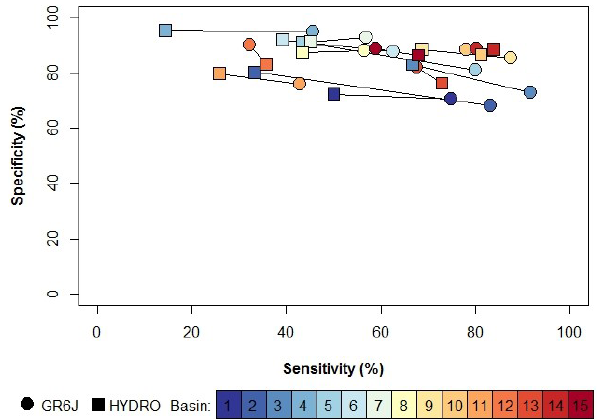
Figure 7. Skill scores obtained for the WRL model over the pe- riod 2005–2013. Each segment is related to one of the 15 catch- ments listed in Table 2. The endpoints refer to the source of dis- charge data (GR6J or